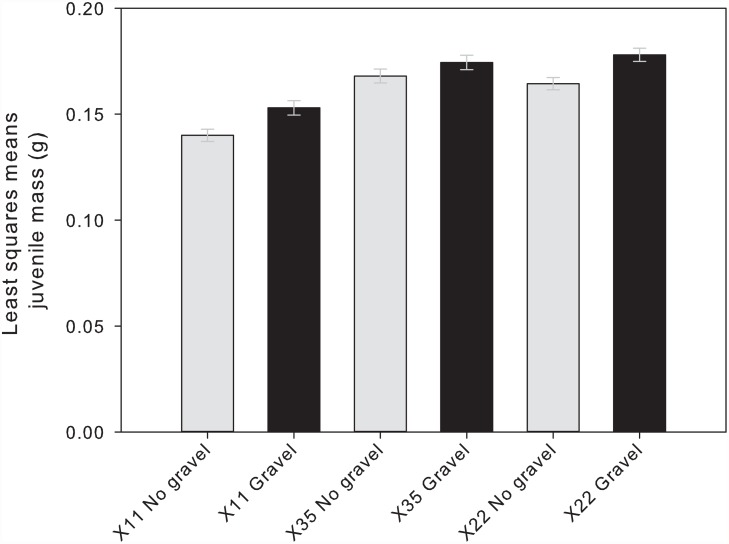
Body mass of juvenile Atlantic salmon from each of three families reared in an unenriched hatchery environment (grey bars) or a hatchery environment enriched with gravel (black bars).Body mass is shown as a least squares means (LSM) estimate derived from ANCOVA, which included fork length as a covariate in the model. Error bars show LSM body mass ± 1 SE.